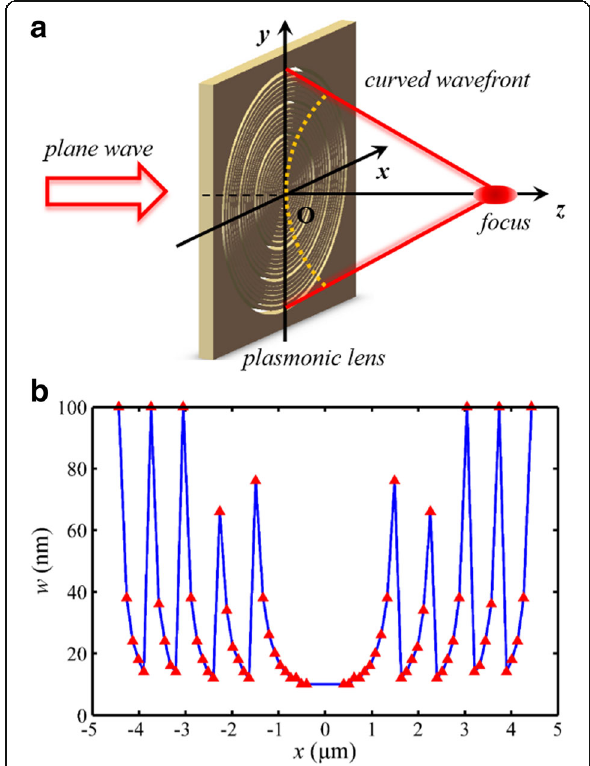
Fig. 2 Schematic of the NRPL. a The incident light normally illuminates the lens. b Structural parameters of the lens. The coordinate values of the red triangles represent the radius r and width w of the corresponding nanoring